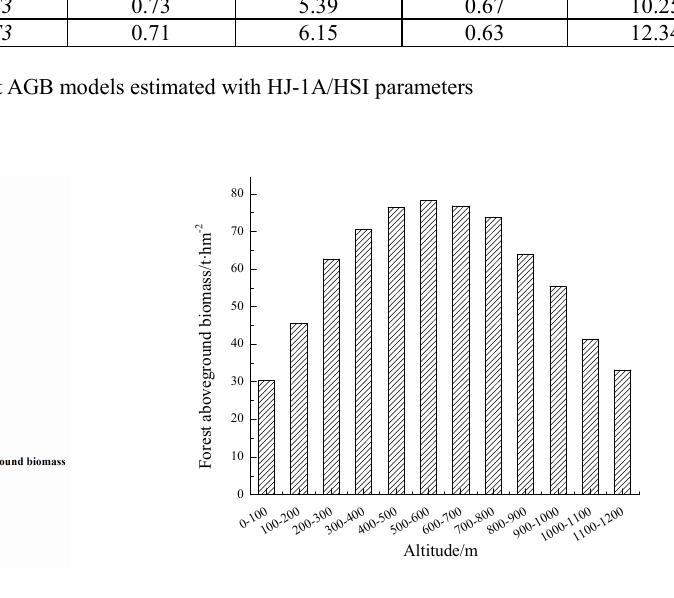
Figure 4. Map of Forest aboveground biomass Figure 5. Forest aboveground biomass with different